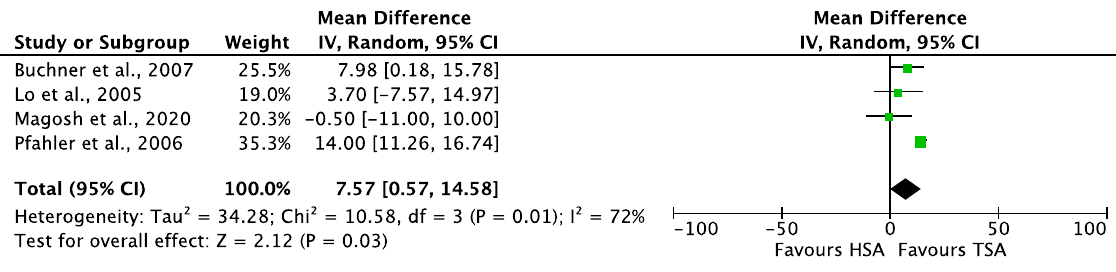
Figure 3. Meta-analysis of the comparison: Age-adjusted Constant score.